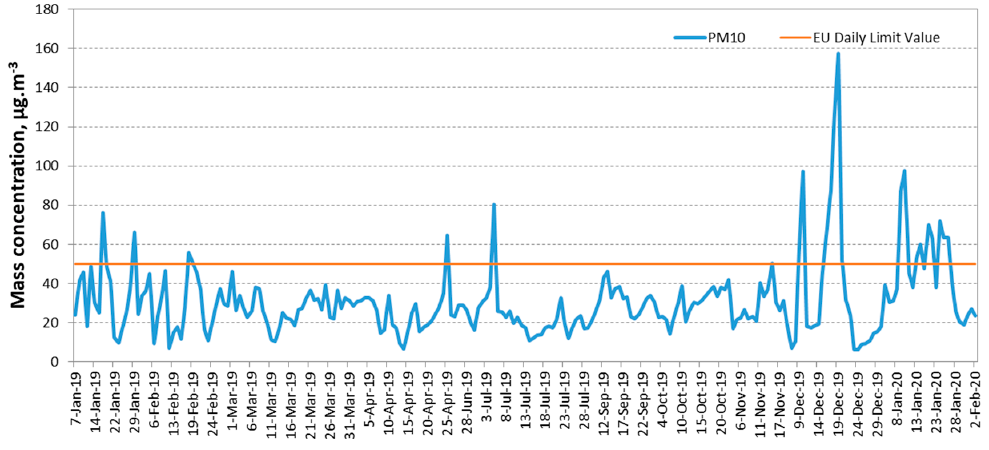
Figure 4. Mass PM10 concentration and daily limit value .